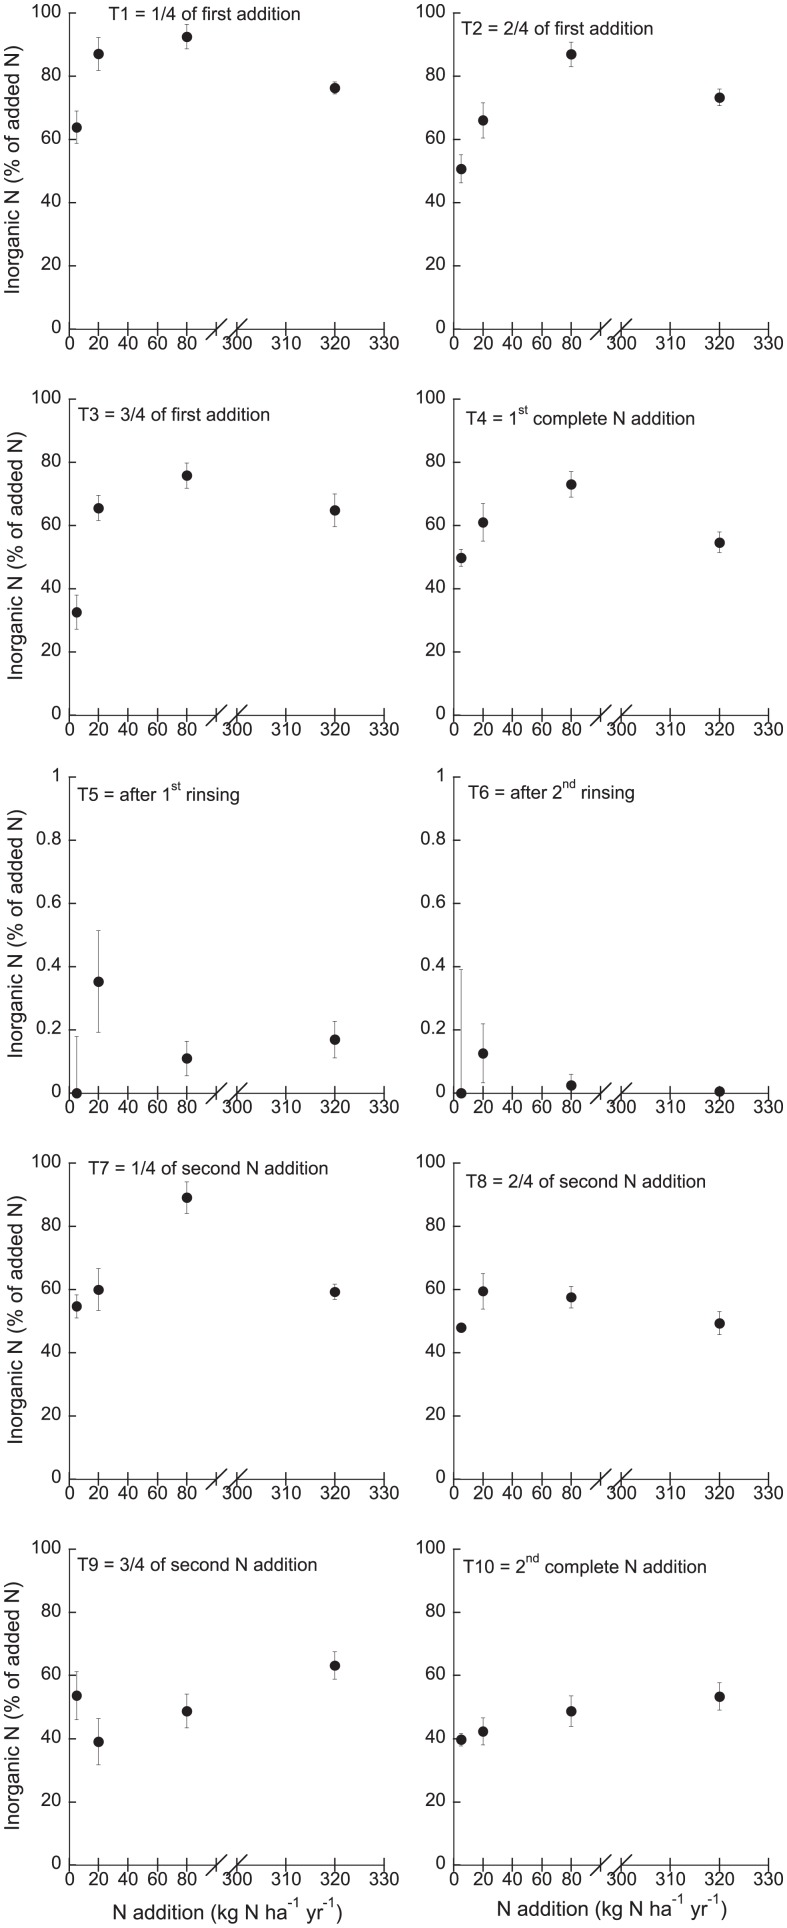
Inorganic N (NH4+ and NO3-) recovered in the leachates over the course of the experiment (% of added N).Given are means ±SE (n = 5). Please note the different y-scale for week 5 and 6 (N deprivation period).